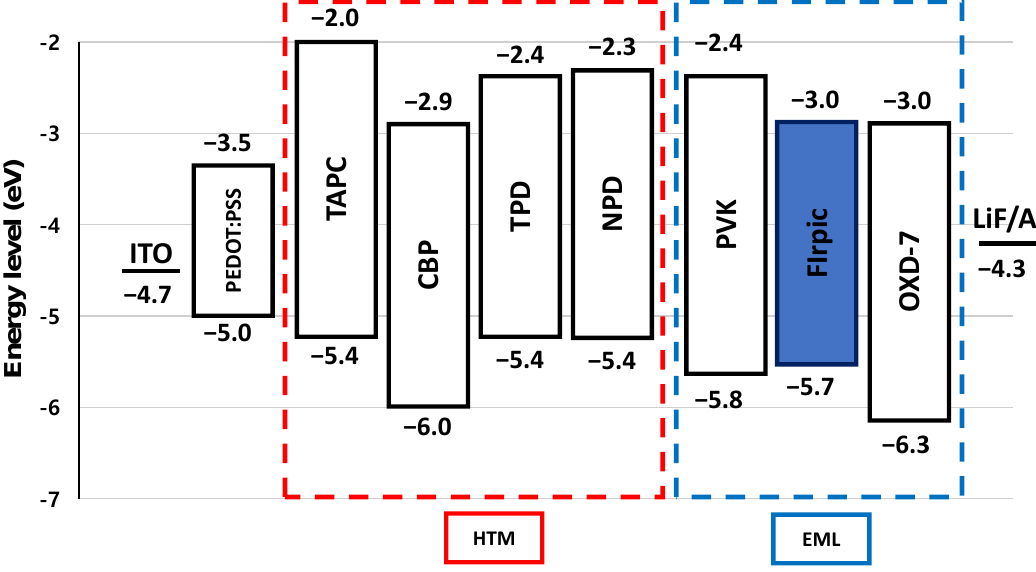
Figure 3. Energy levels of various HTMs and solution-processed blue EML components.